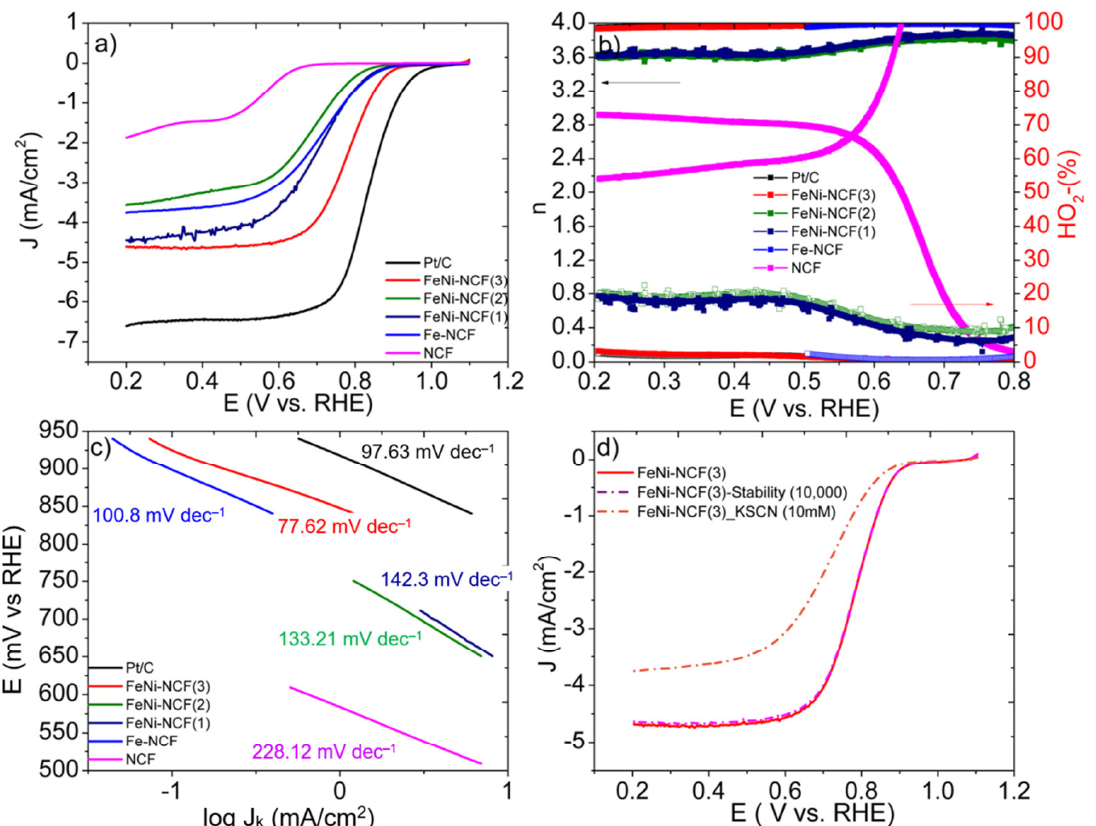
Figure 4. ( a ) ORR polarization curves of the sample series in an oxygen-purged 0.1 M KOH solution. Potential sweep rate 10 mV s − 1 , rotation rate 1600 rpm. ( b ) Electron transfer number (left y -axis) and H 2 O 2 % yield (right y -axis) for the electrocatalysts in ( a ), and ( c ) the corresponding Tafel plots. ( d ) ORR polarization curves in the first scan and after 10,000 potential cycles within +0.2 to +1.1 V,